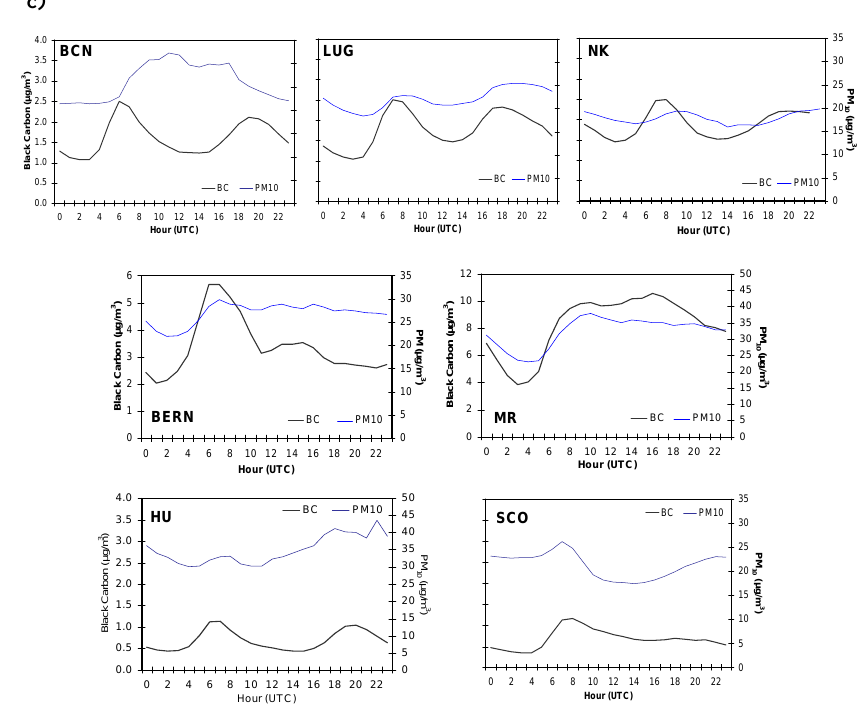
Fig. 2c. Daily cycle of: BC and PM 10 levels for each monitoring site.